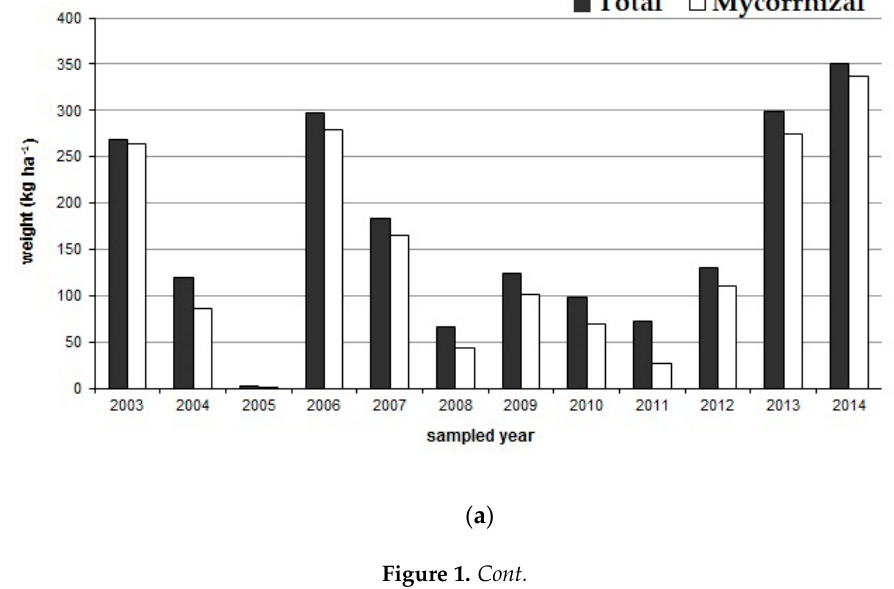
( b ) Figure 1. ( a ) Average total and mycorrhizal fresh weight (kg ha − 1 ) production by sampled year. ( b ) Average total, edible and marketed fresh weight (kg ha − 1 ) production by sampled year. Table 2. Total fresh weight (fw kg ha − 1 ), dry weight (dw kg ha − 1 ) and number of sporocarps per hectare (ns ha − 1 ) by plot and sampled year. Plot